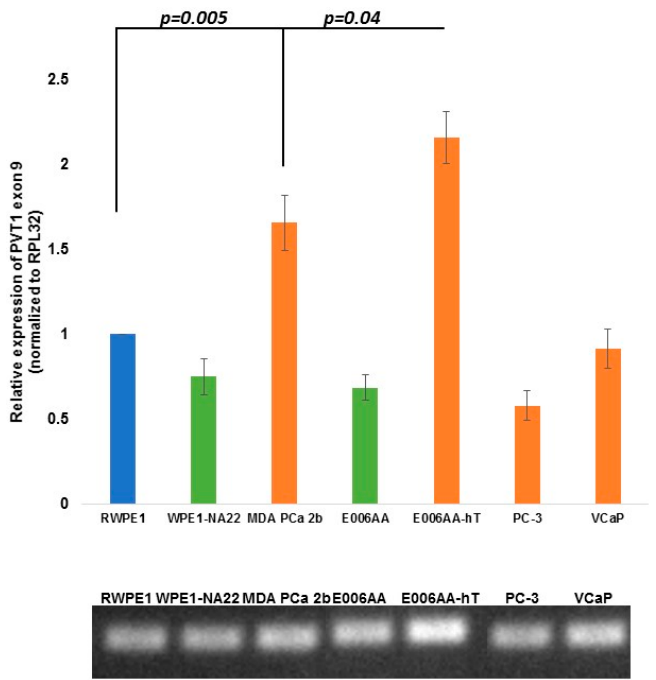
Figure 6. PVT1 exon 9 overexpression in aggressively tumorigenic PCa cell line from MoAA. Five independent qPCR experiments were performed and every experiment was set up in quadruplicates. The data showed that PVT1 exon 9 is consistently significantly overexpressed in the aggressive PCa cell lines derived from MoAA in comparison to the non-tumorigenic PCa cell line it was derived from. The data are presented as mean + standard error of the mean (SEM) and the p values are displayed on the figure. The lower panel shows the different prostate cell lines’ PVT1 exon 9 PCR products loaded on a 0.8% agarose